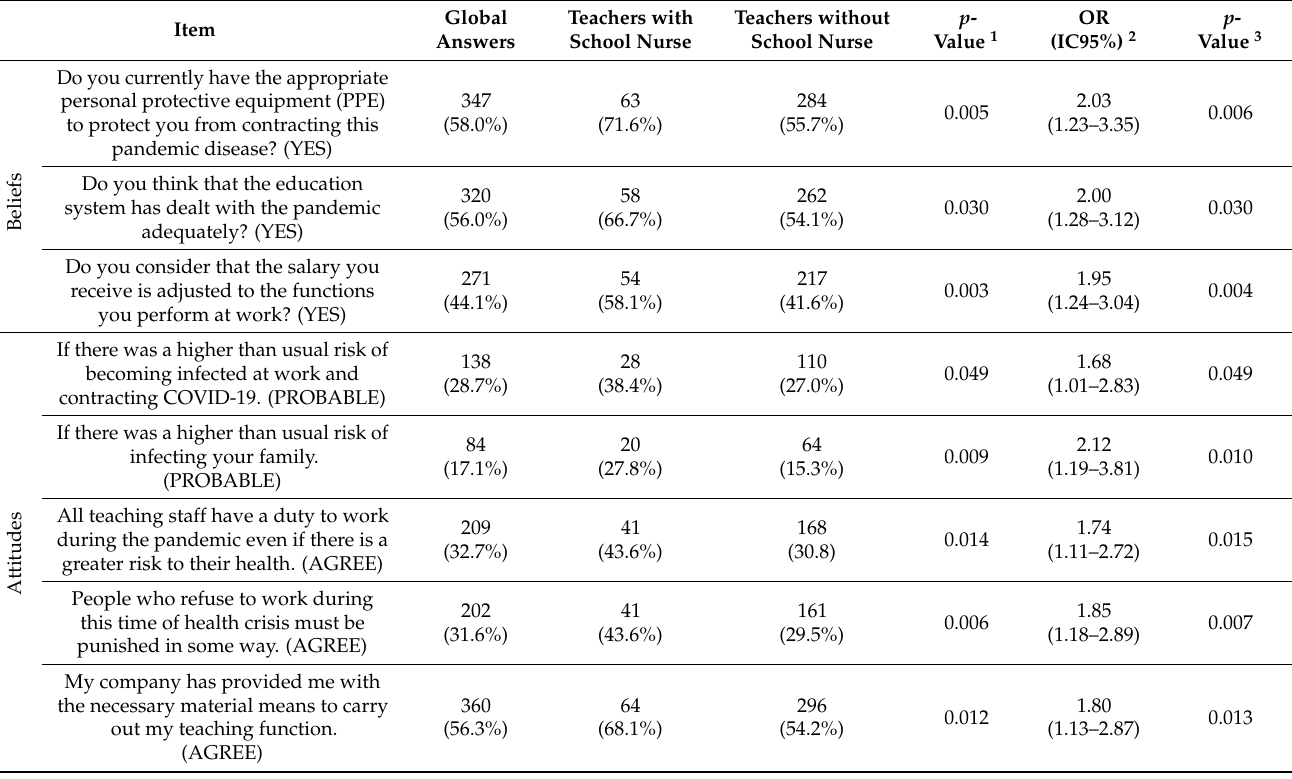
Table A4. Answers given to the items in the sections of the questionnaire globally and according to whether or not the teachers have a health professional in their educational center (only those with a significant difference are shown).